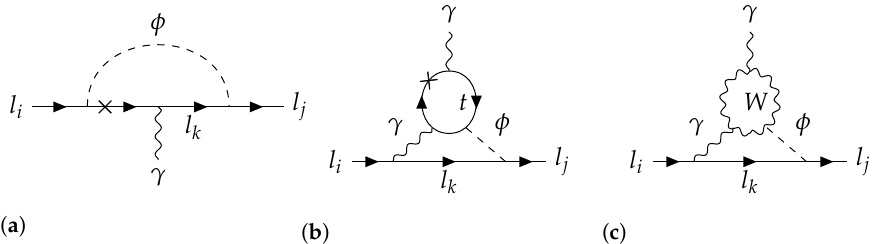
Figure 7. Diagrams for l i → l j γ in the 2HDM, where φ = h , H , A . Two-loop Bar-Zee diagrams with a Z exchange also exist. ( a ) One loop contribution to the l i → l j γ rate in the 2HDM with LFV Yukawa couplings. ( b ) Two loop Barr-Zee diagram with a top loop contributing to l i → l j γ in the 2HDM with LFV Yukawa couplings. ( c ) Two loop Barr-Zee diagram with a W loop contributing to l i → l j γ in the 2HDM with LFV Yukawa couplings.